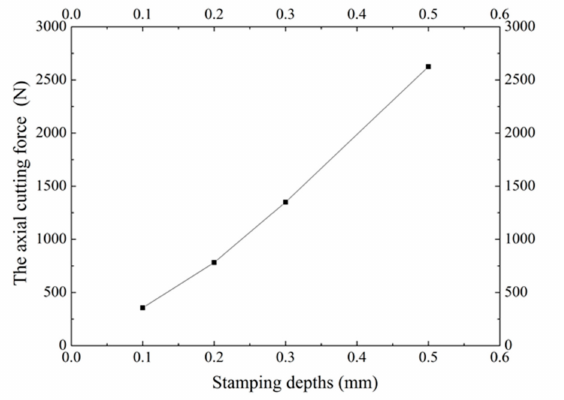
Figure 9. Axial cutting force under di ff erent stamping